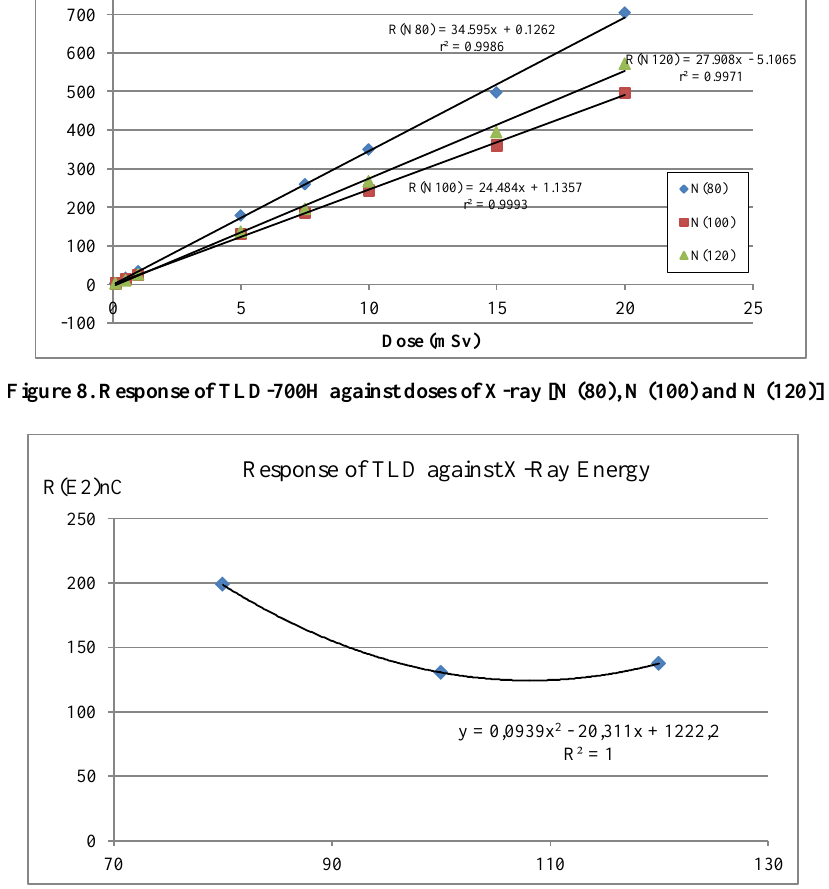
Figure 9. Response of TLD against energies of X-ray (at 5